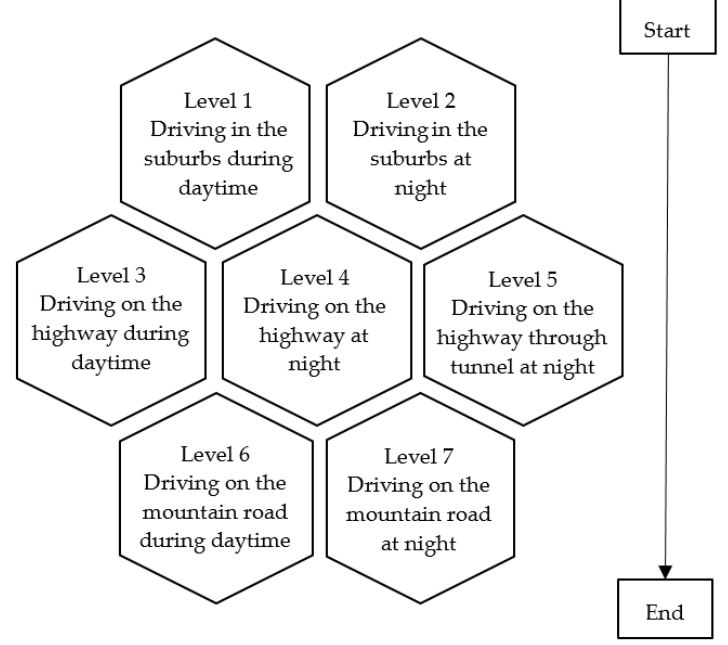
Figure 2. Scenario design level chart.